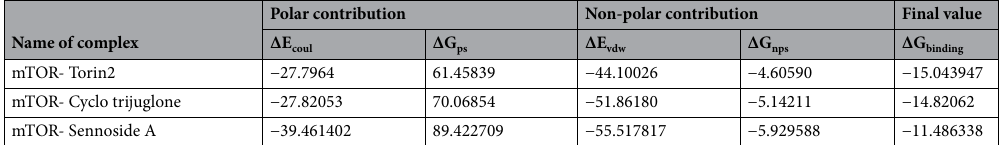
Table 1. Binding free energies for protein–ligand complexes calculated with the MM/PBSA method for the MD simulations